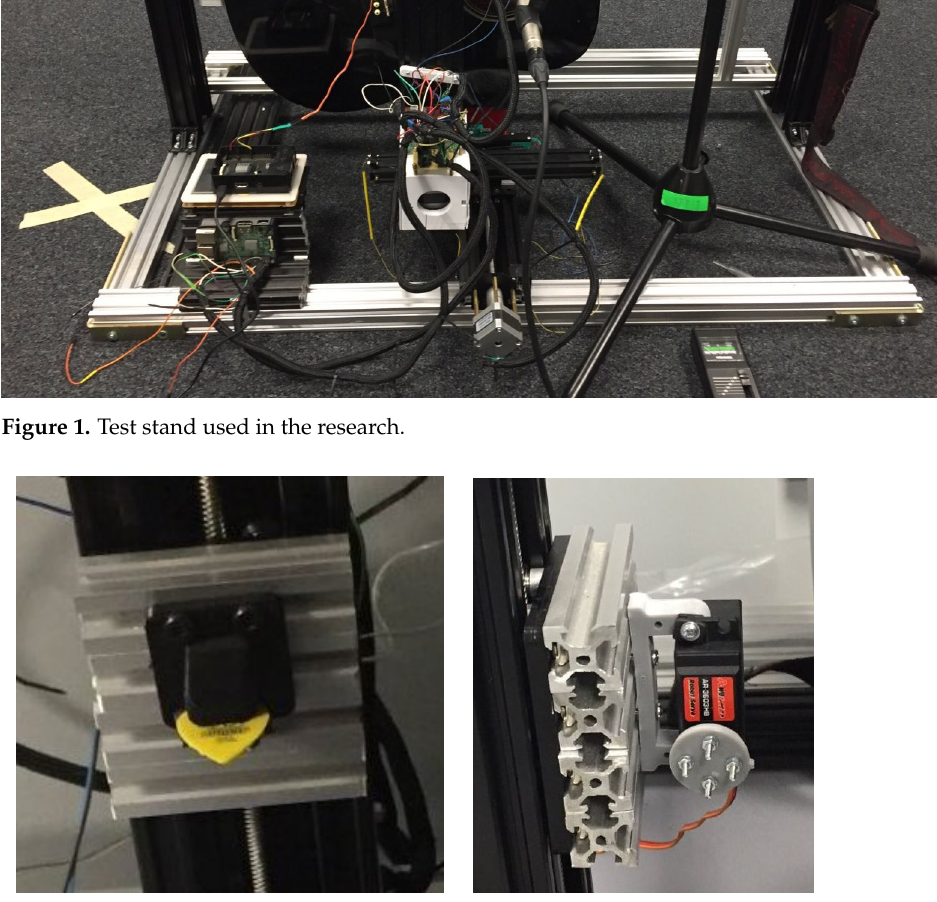
Figure 2. ( a ) End effector based on a standard guitar plectrum; ( b ) EOAT based on the proprietary re-excitation